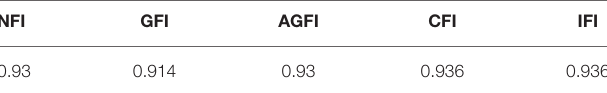
TABLE 4 | Model fit summary of structural equation modeling ( N =